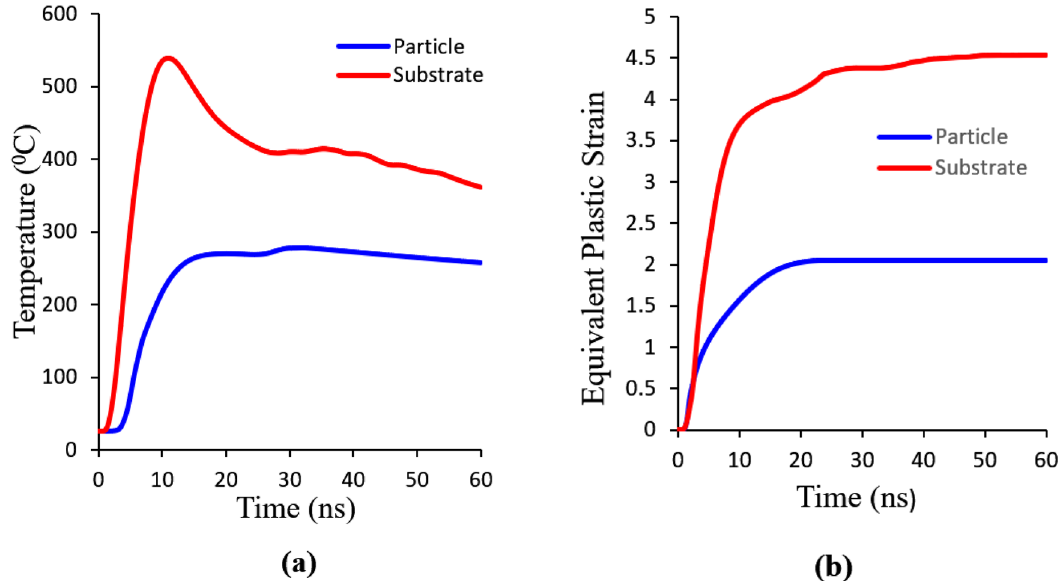
Fig. 4. The time distribution of (a) temperature (b) PEEQ of Cu/Al impact using the Lagrangian numerical modelling at 500 m/s impact